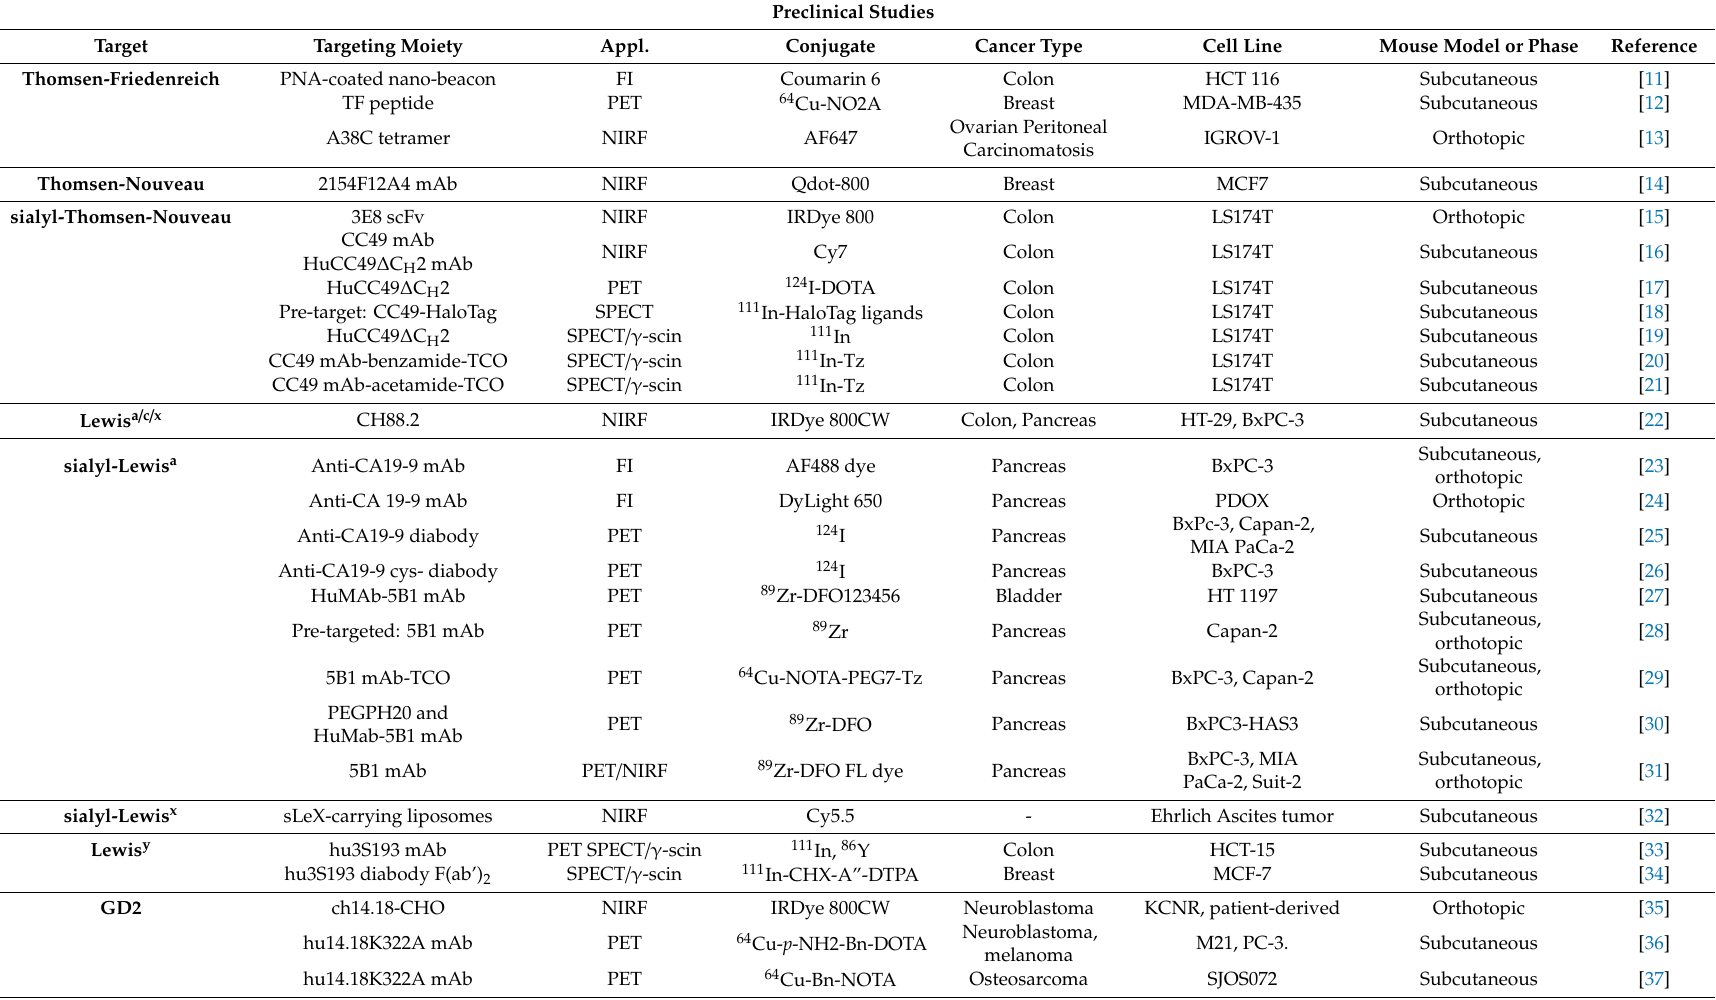
Table 1. An overview of recent imaging studies evaluating glycans and heavily glycosylated